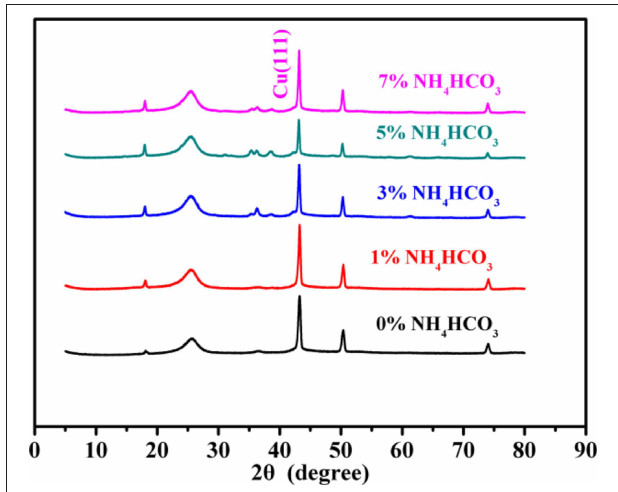
FIGURE 2 | XRD patterns of the carbon cathode